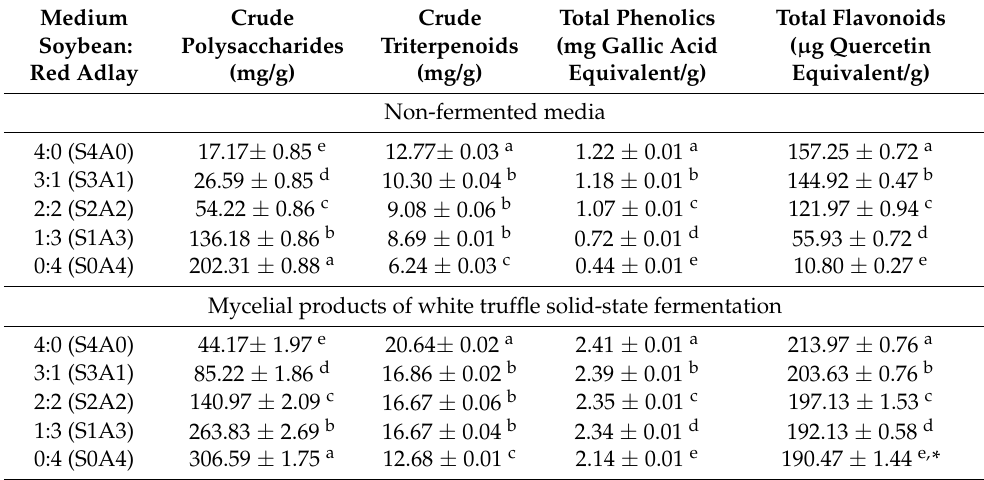
Table 2. Effects of different mixed media on bioactive components in non-fermented media and mycelial products of white truffle solid-state